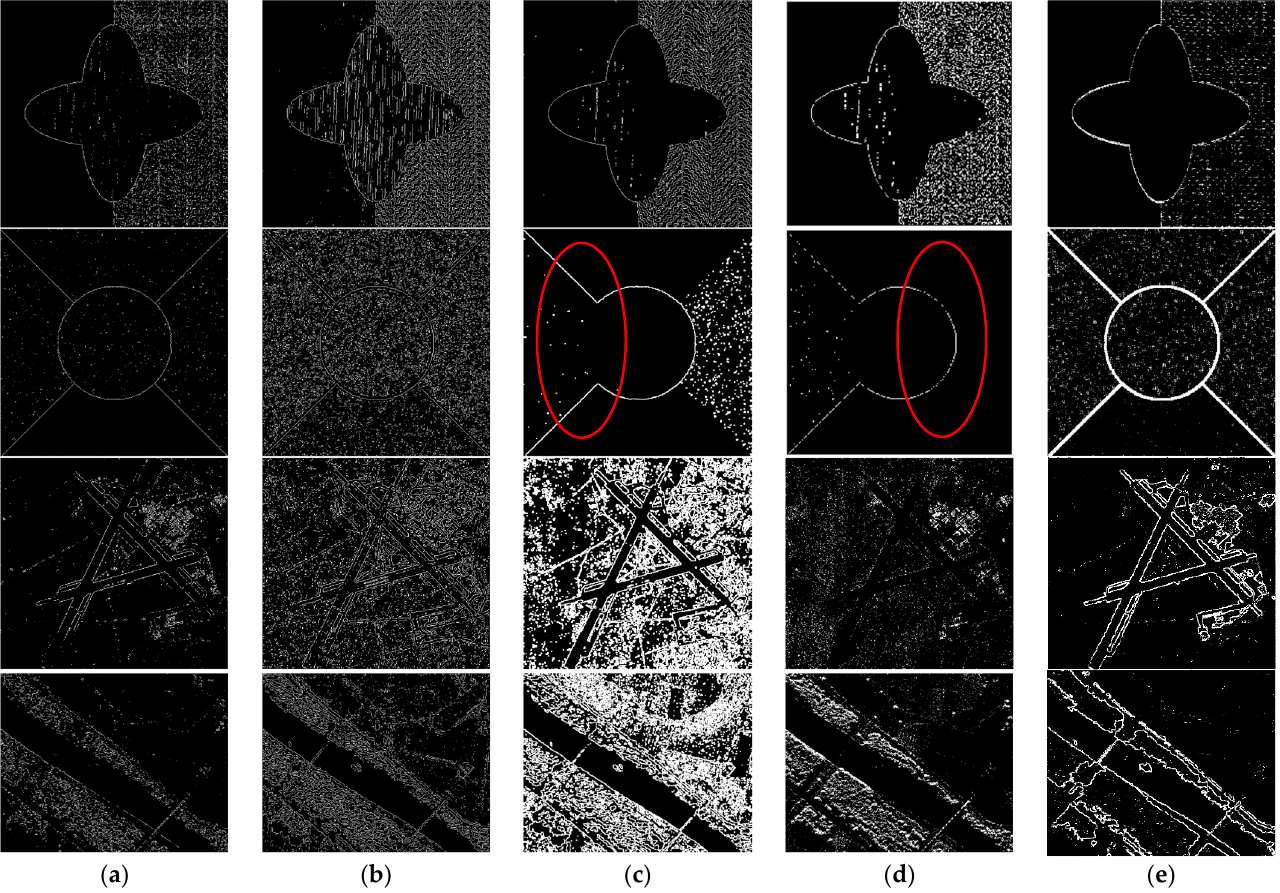
Figure 11. Five edge extraction results for four images. ( a ) Sobel, ( b ) Log, ( c ) SDREL, ( d ) fuzzy logic, and ( e ) the proposed method.